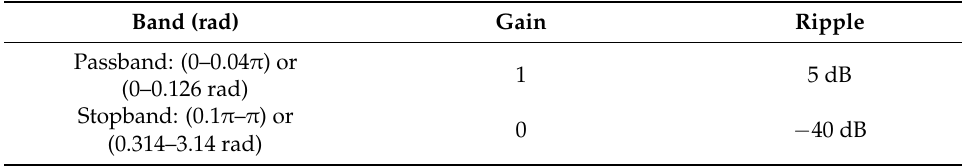
Figure 10. ( a ) The DFT magnitude of the TOA sequence seen by Anchor 1. ( b ) A magnified view. Table 1. SDM reconstruction LPF specifications.